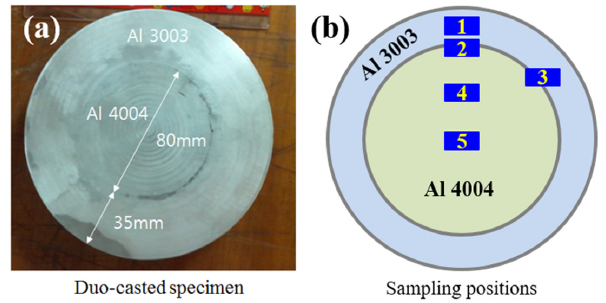
Figure 1. ( a ) Dimension and shape, and ( b ) specimen sampling positions of an electromagnetic duo-casted Al3003 / Al4004 clad